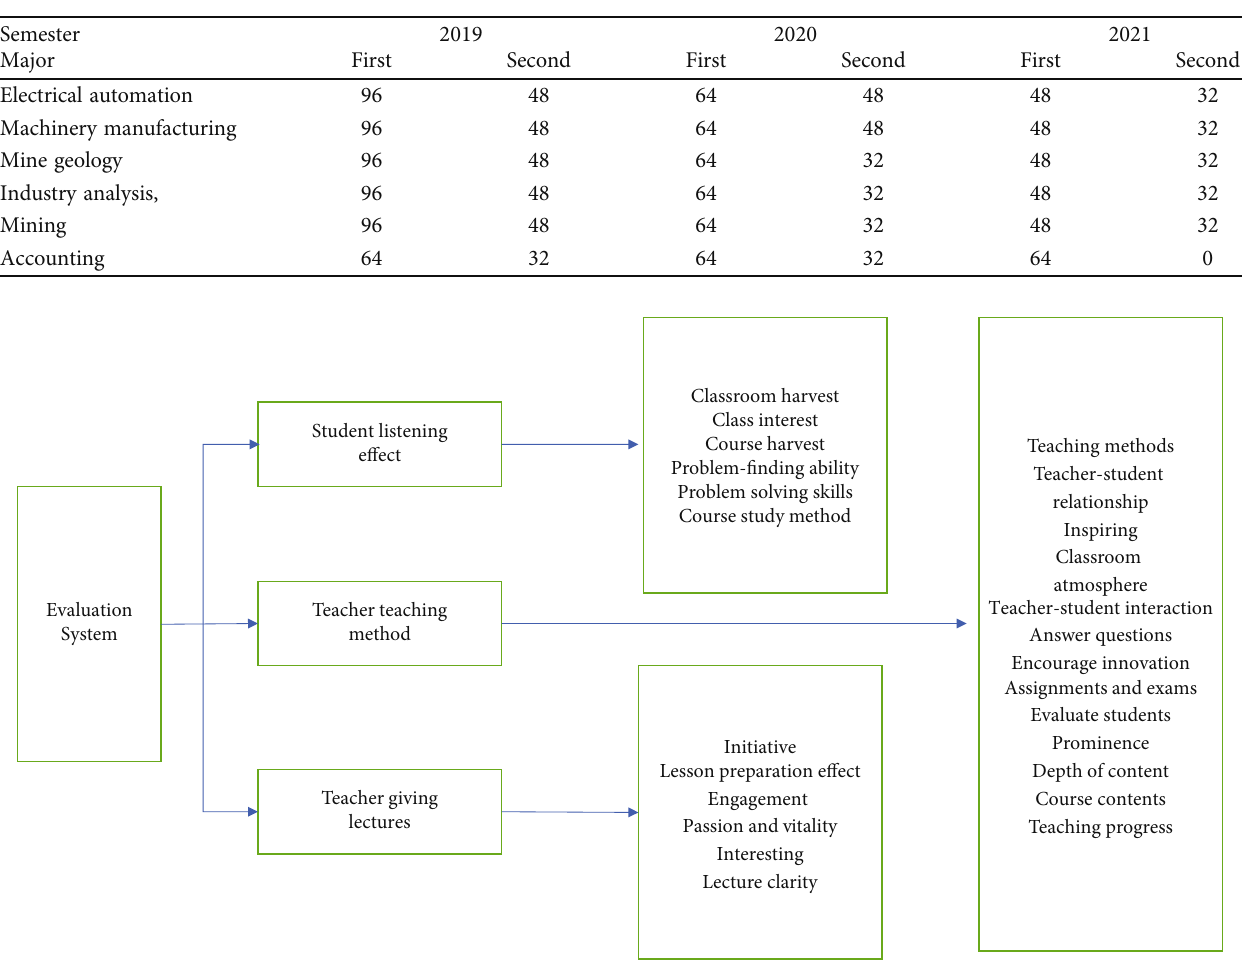
Table 6: Statistical table of class hours for some majors of the college.